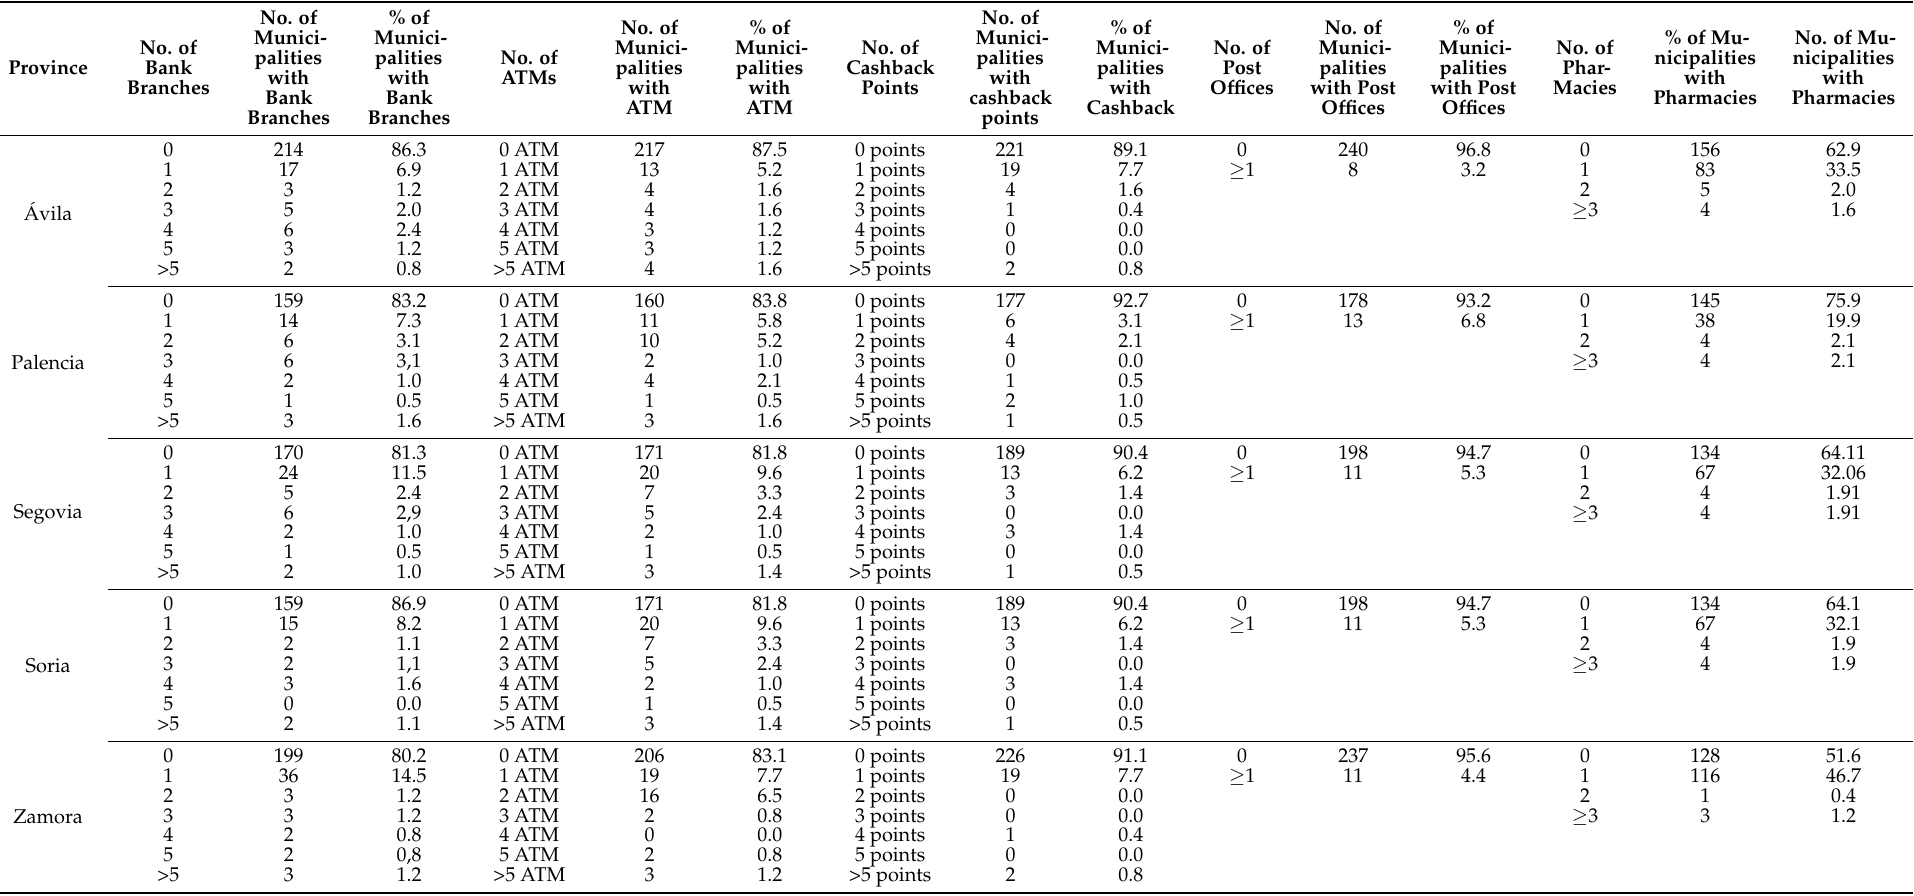
Table A1. Bank branches, ATMs, cashback points, post offices and pharmacies by province and